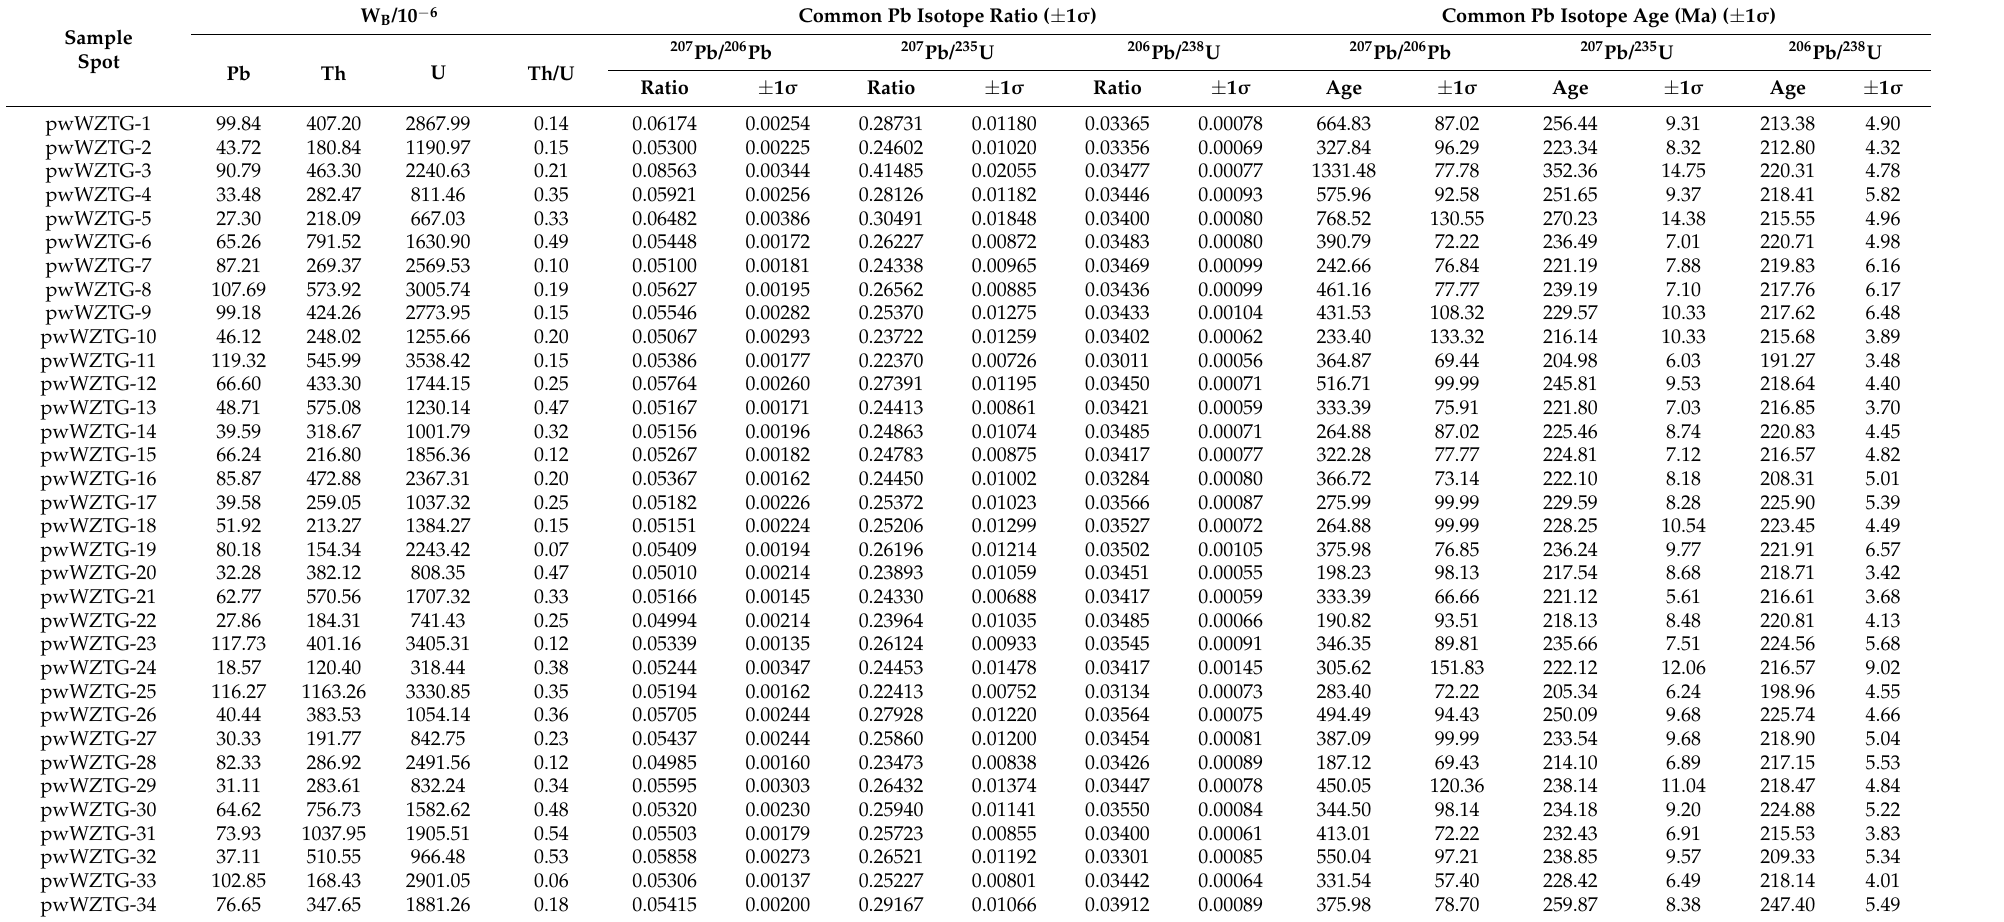
Table 1. LA-ICP-MS U–Pb isotopic data for zircon in the Wuzhutang granite from the Xuebaoding mining